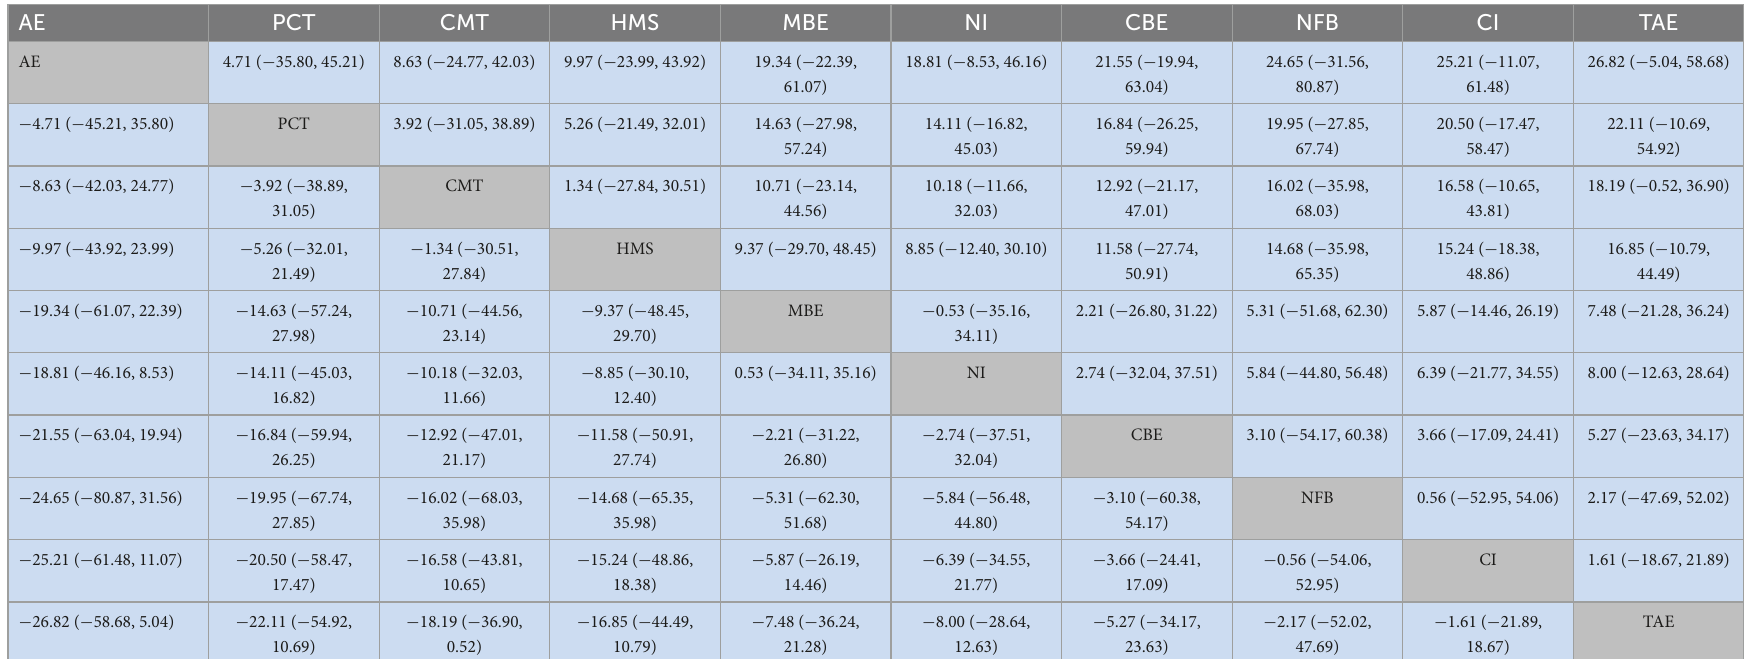
TABLE 3 League table on attention